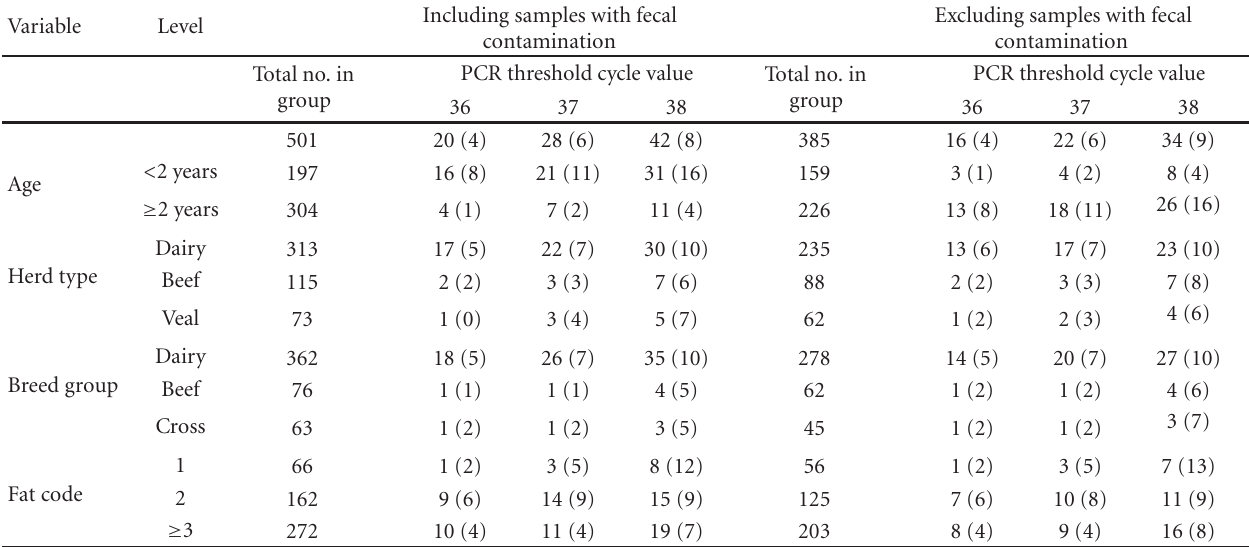
Table 1: Number- and group-specific percentage (in brackets) of muscle tissue samples from slaughtered cattle from which Mycobacterium avium subsp. paratuberculosis DNA was detected by IS 900 PCR at threshold cycle value of 36, 37, and 38 by age, type, of herd, breed type and fat code. Positive results were defined in relation to possible fecal contamination to the tissue samples.